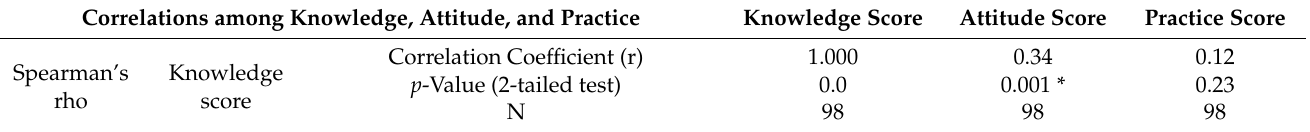
Table 4. Spearman’s correlation test for correlations among knowledge, attitude, and practice scores. Correlations among Knowledge, Attitude, and